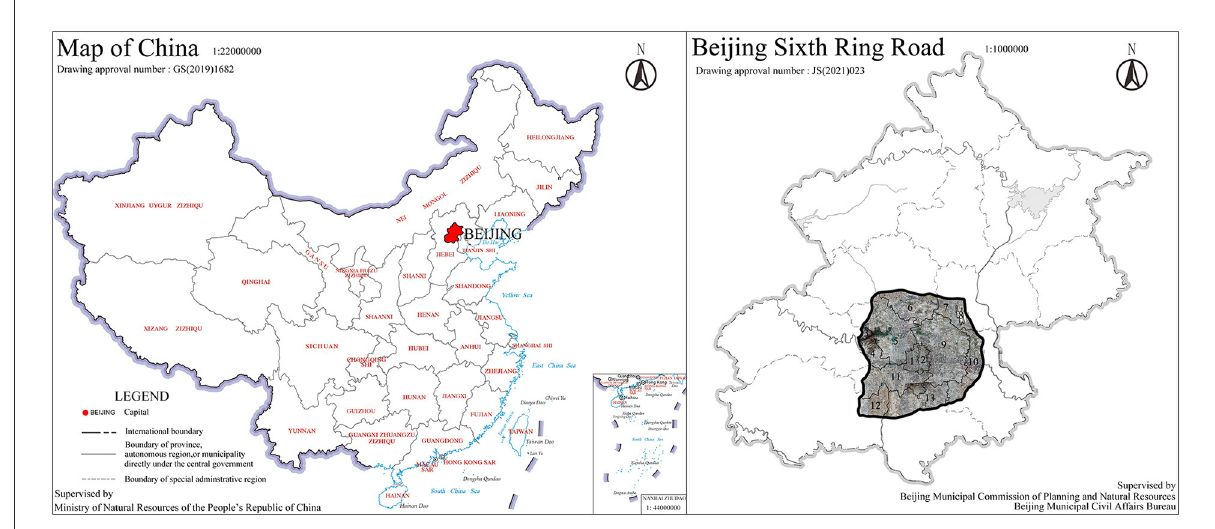
FIGURE1 The location of study area (1: Xicheng District ; 2: Dongcheng District ; 3: Mentougou District ; 4: Shijinshan District ; 5: Haidian District ; 6: Changping District ; 7: Shunyi District ; 8: Beijing Capital International Airport ; 9: Chaoyang District ; 10: Tongzhou District ; 11: Fengtai District ; 12: Fangshan District ; 13: Daxing